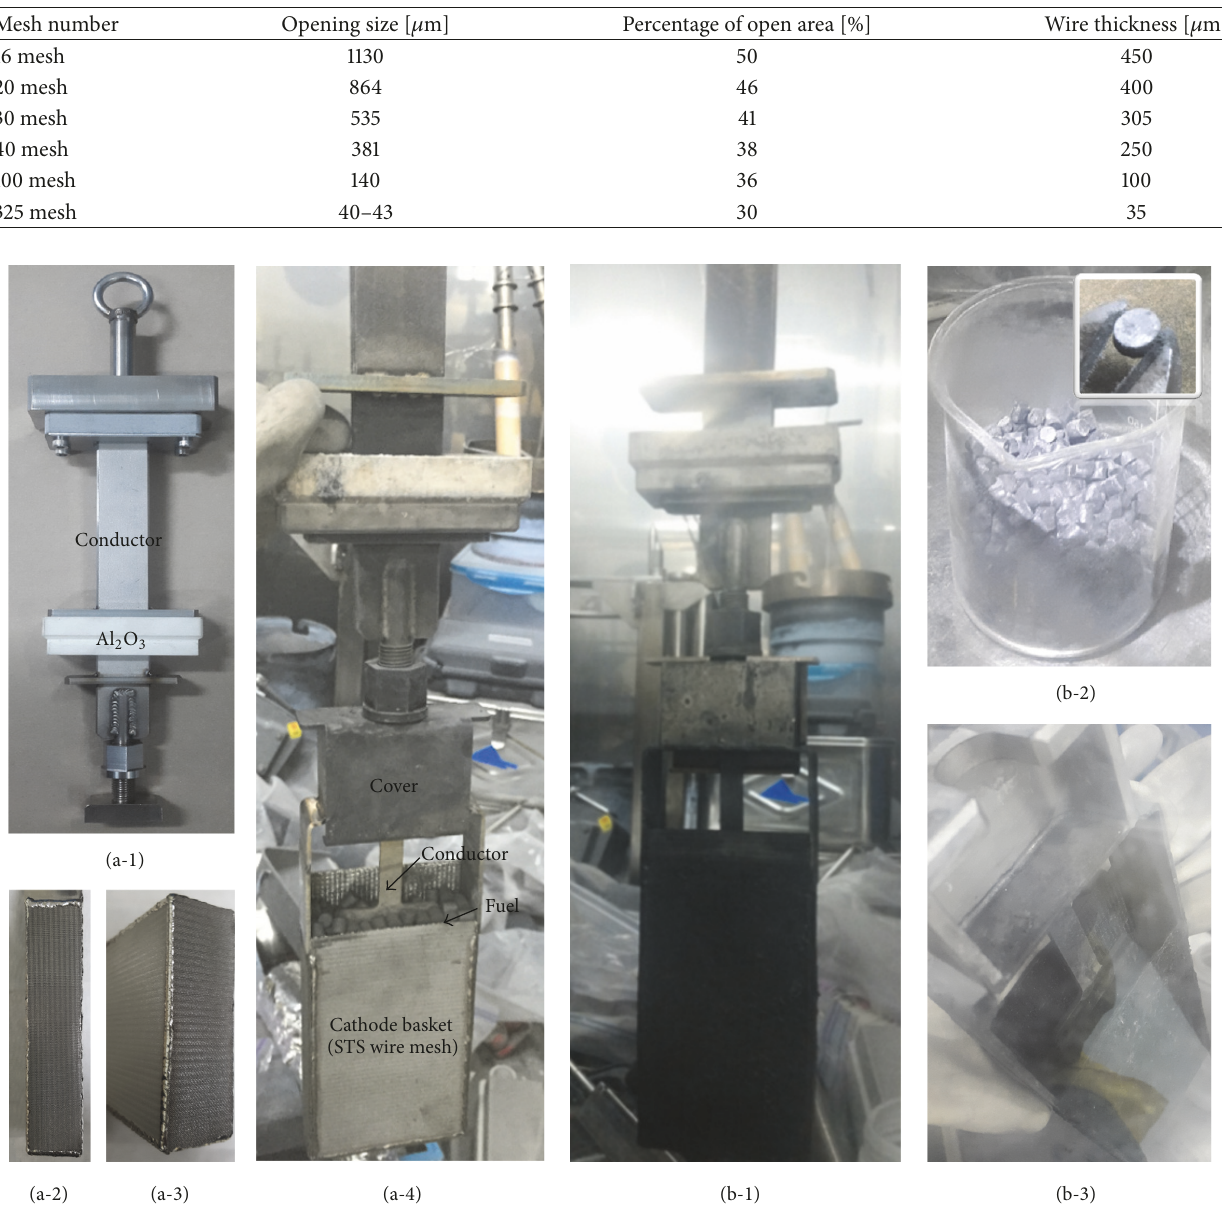
Figure 2: Images of the cathode before the OR (a-1) Ni conductor containing Al 2 O 3 insulator, (a-2) side view and (a-3) bottom view, (a-4) the assembly, (b-1) the cathode basket used after the OR, (b-2) the separated reduction product from the basket, and (b-3) the emptied basket after the